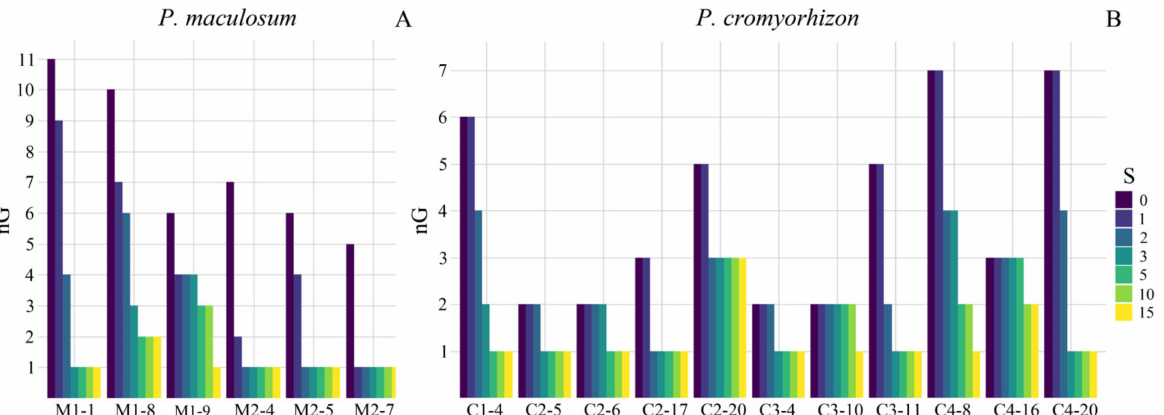
Figure 1. Number of genotypes (nG) considering varying numbers of mutational steps (S). ( A ) Genotype numbers in the progeny of six apomictic genotypes from two populations of P. mac- ulosum . ( B ) Genotype numbers in the progeny of 11 apomictic genotypes of four populations of P. cromyorhizon . Apomictic genotypes with all clonal progeny considering S = 0 are not presented (C1-20, C2-15, C3-15 and 19, C4-3 and 12). With increasing S, the nG decreased in nearly all the progenies. nG = 1 indicates that all the offspring have the maternal genotype. In P. cromyorhizon , we analyzed the offspring from two maternal apomictic genotypes in C1, and five maternal apomictic genotypes in the remaining three populations (Table 3). ering S = 3, Tables 3 and S4). All maternal apomictic genotypes of P. cromyorhizon showed